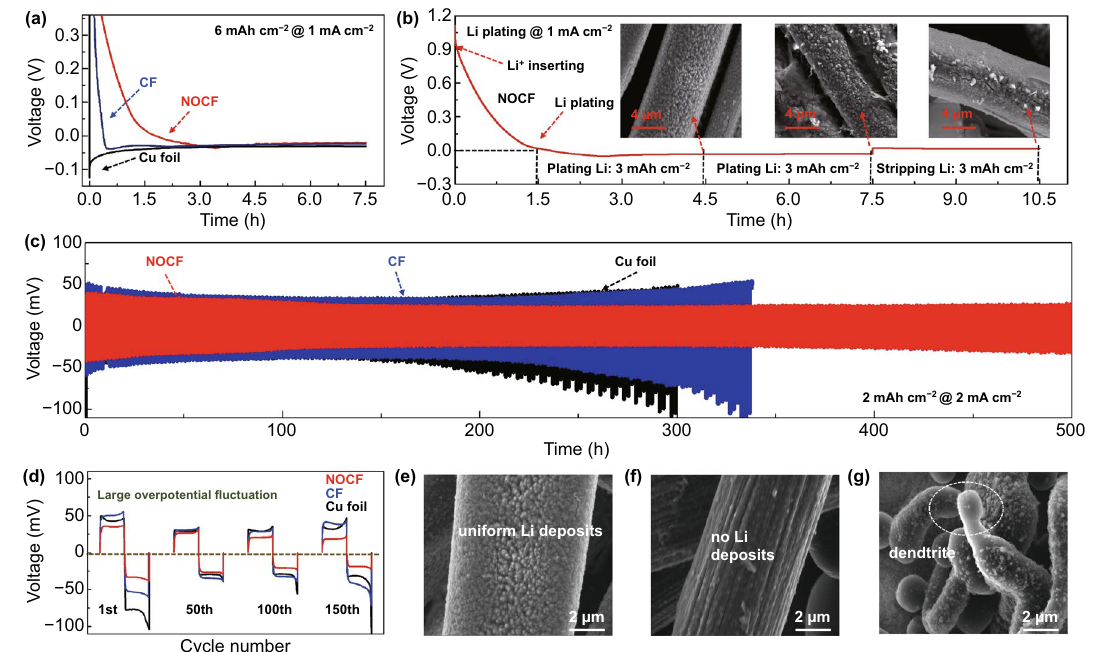
Fig. 2 a First discharge voltage profiles for Li nucleation onto various hosts of NOCF, CF, and Cu foil at 1.0 mA cm −2 . b Galvanostatic charge/ discharge profile of NOCF (vs. Li metal) at 1.0 mA cm −2 , and corresponding SEM images after electroplating 3.0 mAh cm −2 and 6.0 mAh cm −2 of Li and then subsequently stripping 3.0 mAh cm −2 of Li. c Galvanostatic plating/stripping profiles of symmetric cells with various Li elec- trodes (Li/NOCF, Li/CF and Li/Cu foil) at 1.0 mA cm −2 . d Galvanostatic plating/stripping profile of various Li anodes at the 1st, 50th, 100th, and 150th cycle. e – g SEM images of Li/NOCF, Li/CF, and Li/Cu foil after plating 3.0 mAh cm −2 of Li metal at 1.0 mA cm